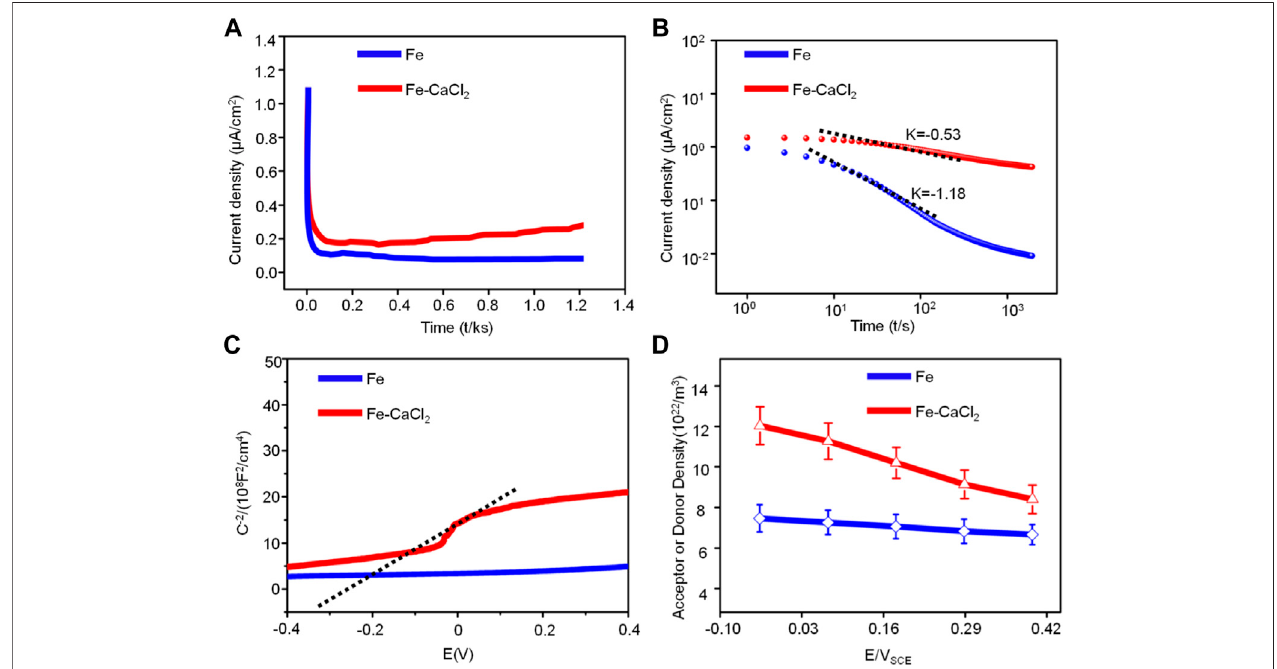
FIGURE9|(A) Thecurrentdensity – timeinlinearand (B) doublelogarithmiccoordinatesplots; (C) Mott – SchottkycurvesofFeandFe/CaCl 2 compositeinSBFand (D) values of donor